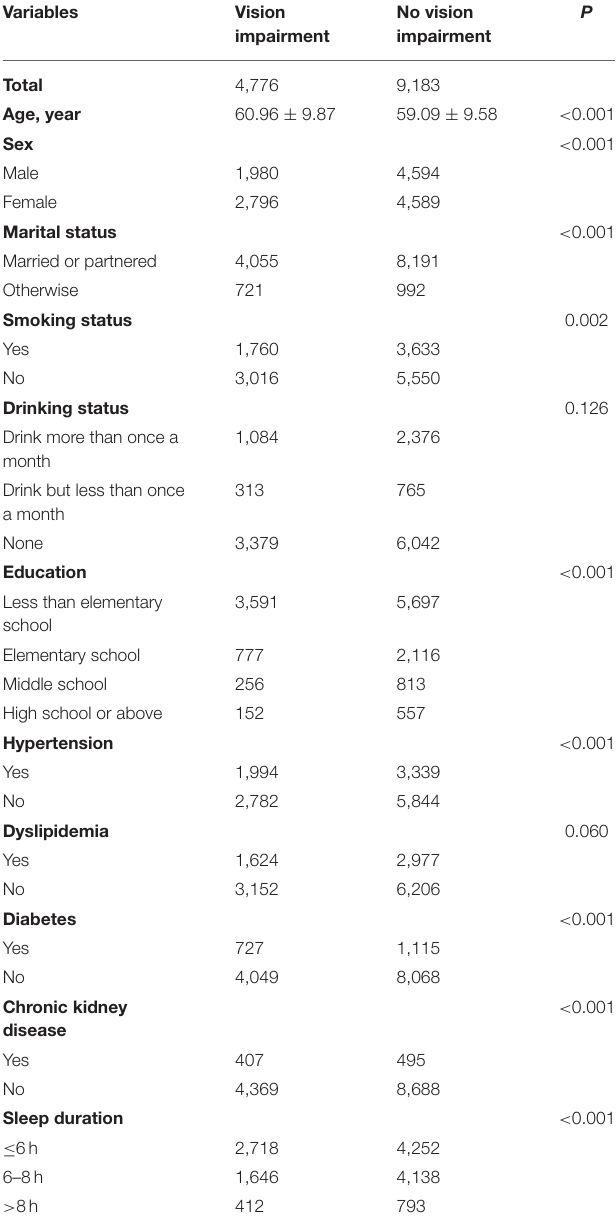
TABLE 1 | Demographic characteristics of middle-aged and elderly Chinese with and without suffering vision impairment (CHARLS 2011–2012).